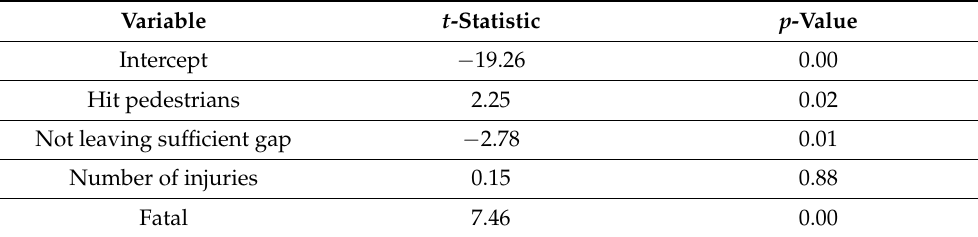
Table 6. The t -statistics and p -values for the coefficients of the utility Equation (6). Variable t